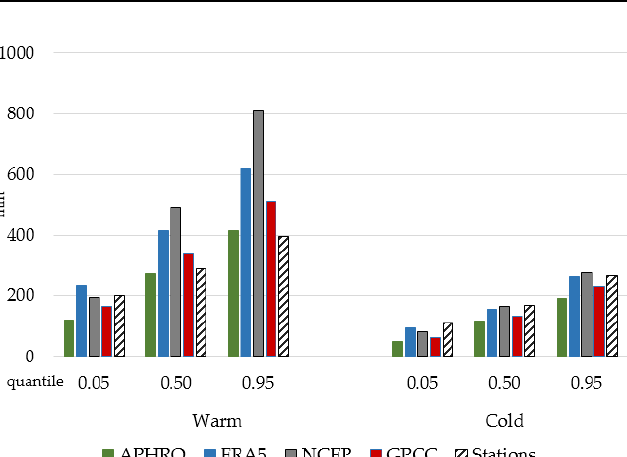
Figure 4. The distribution of the precipitation values in the warm and cold seasons by the threshold quantiles. Visualization of the data presented in Table 1.